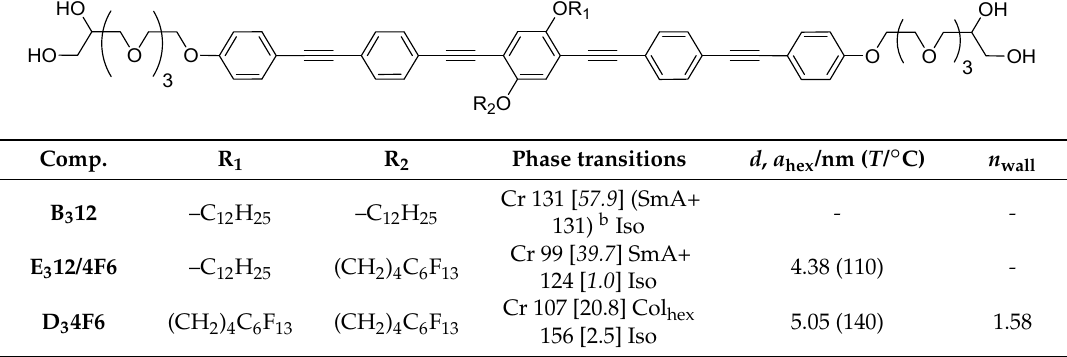
Table 5. Comparison of the mesophases, phase transition temperatures ( T /°C), corresponding enthalpy values ( Δ H /(kJ·mol − 1 ), in square brackets), and other parameters, depending on the degree of lateral chain fluorination at almost identical side chain volume a .